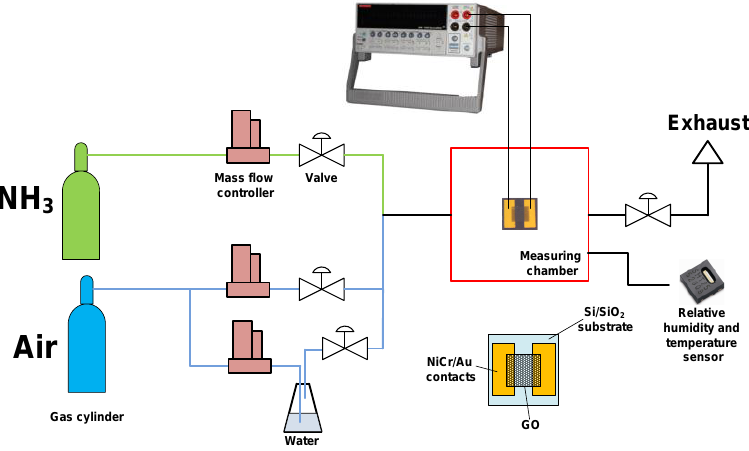
Figure 1. Scheme of gas rig for chemiresistive GO-based ammonia gas sensor characterization.